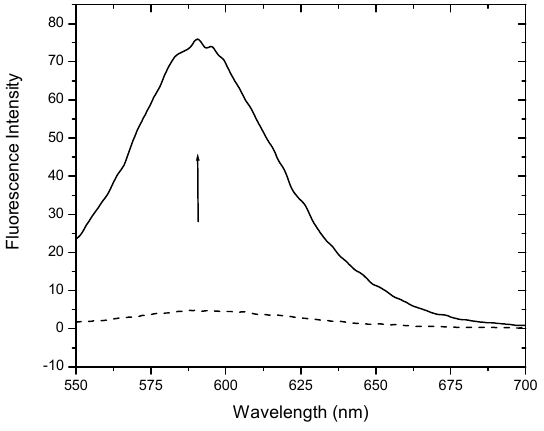
Figure 3. Fluorescence emission spectra of ethidium in the absence (dashed line) and presence (solid line) of a saturating concentration of the DNA aptamer 1OLD.